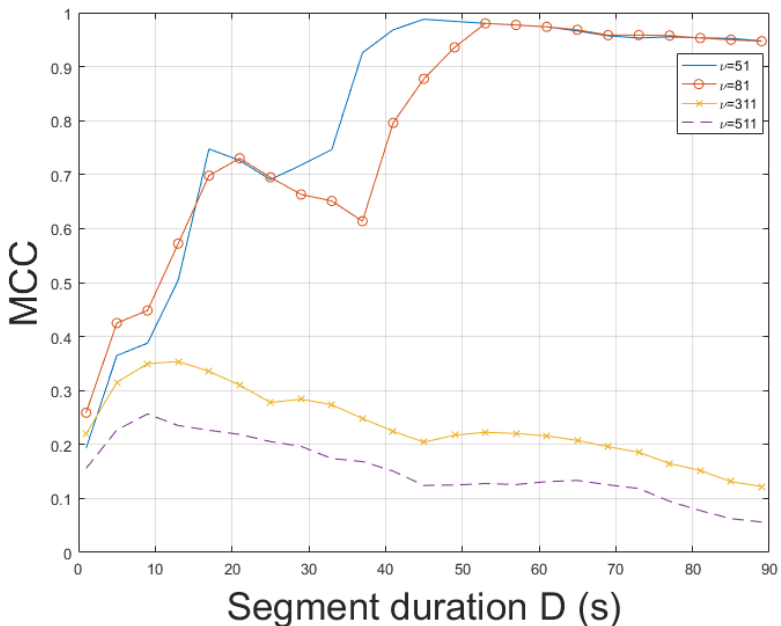
Figure 7. Maximum correlation coefficient of the proposed approach employing SLIC+STFT for various bandpass filter orders and segment durations